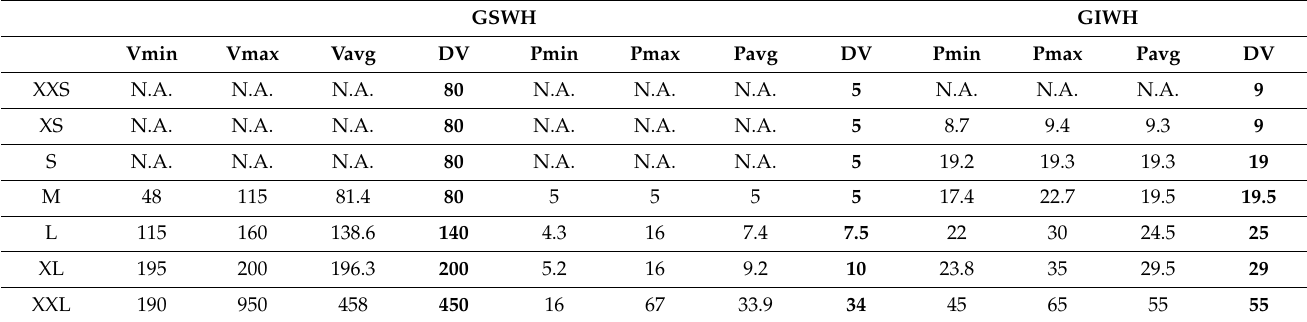
Table A5. Default values of volume and nominal capacity for gas water heaters.